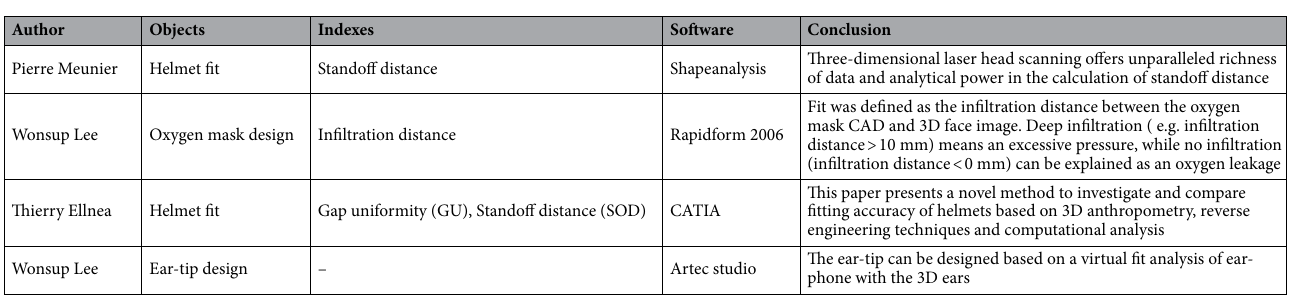
Table 1. Ergonomic researches which used the deviation